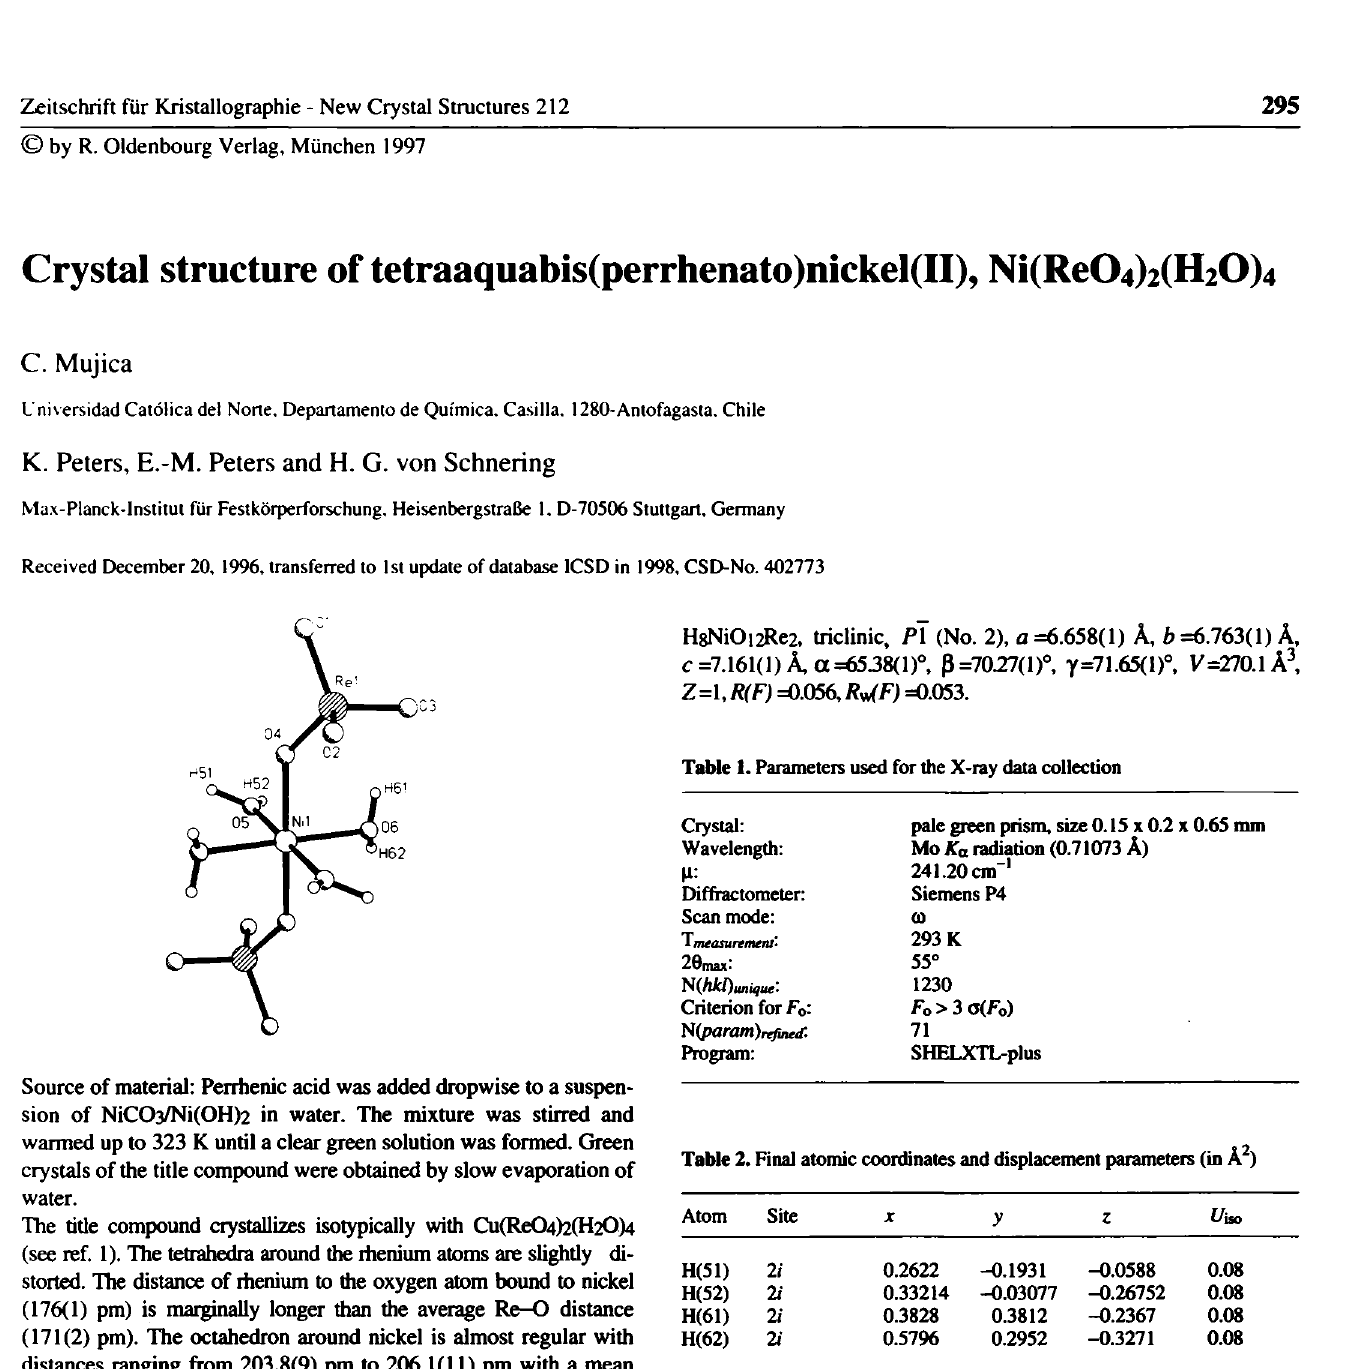
Table 3. Final atomic coordinates and displacement parameters (in Â 2 ) Atom